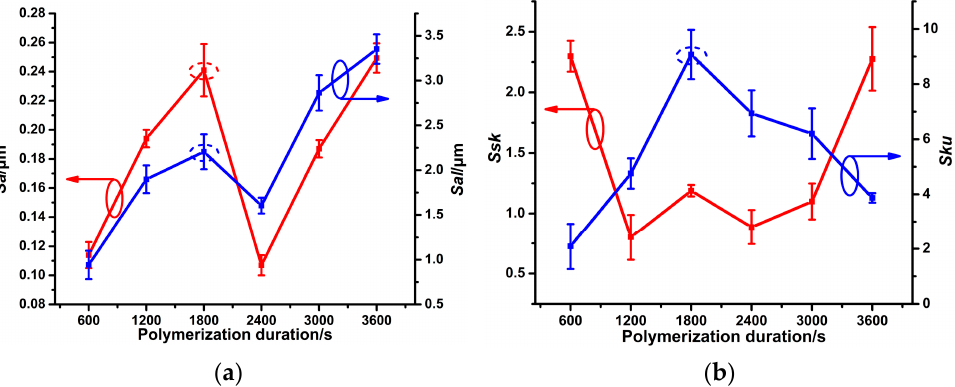
Figure 3. Effect of the polymerization duration on Sa and Sal ( a ), as well as Ssk and Sku ( b ), of the PPy(NO 3 − )-ISMs.